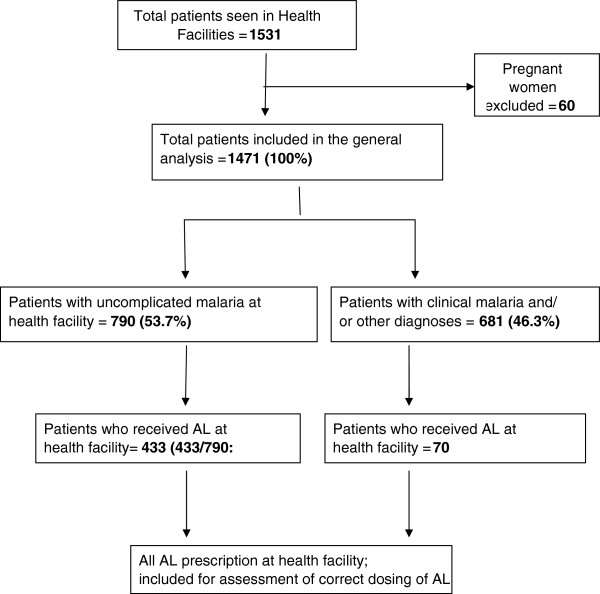
Distribution of study participants.